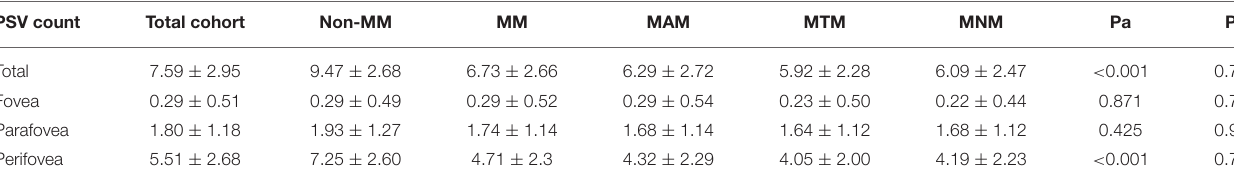
TABLE 3 | PSV count in different regions and comparison among different myopic